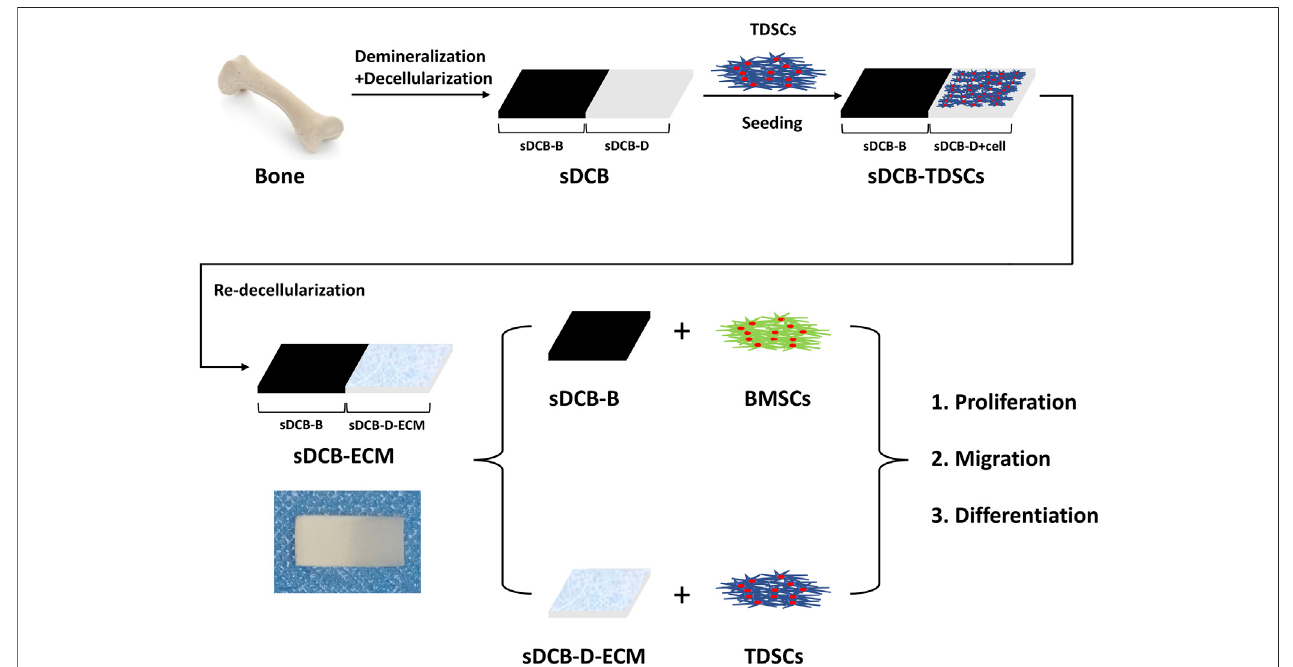
FIGURE 1 | Schematic illustration of the preparation of sDCB-ECM and in vitro study.